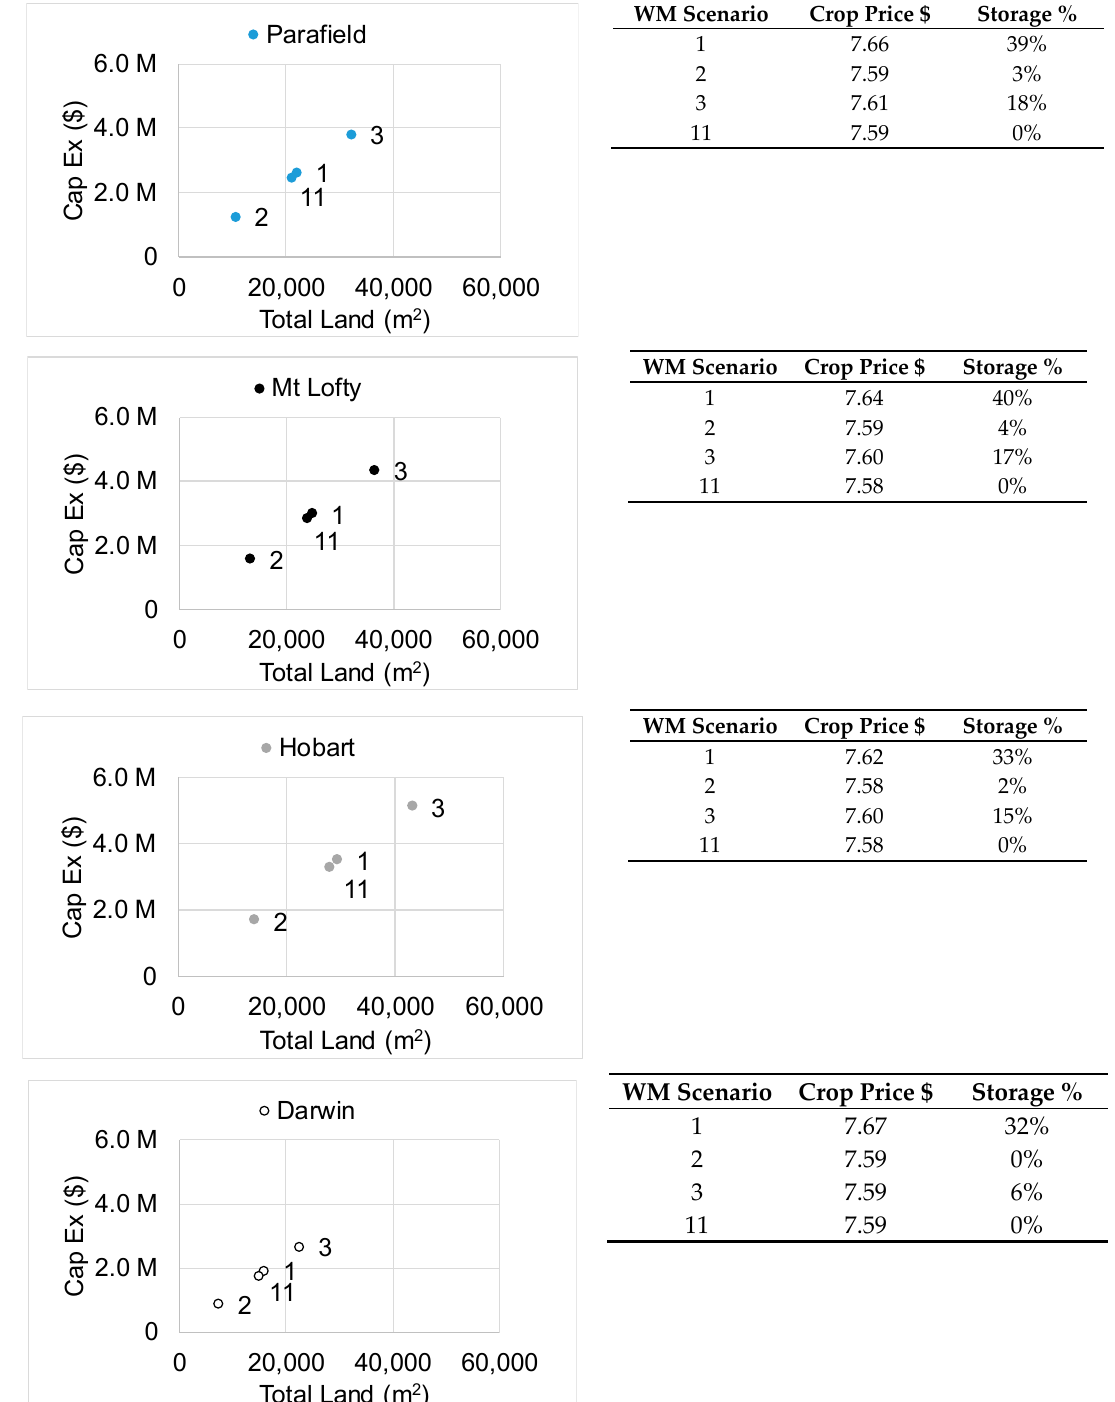
Figure 13. Hydroponic reuse in greenhouse conditions (HYDRO-GH) across four Australian climates.